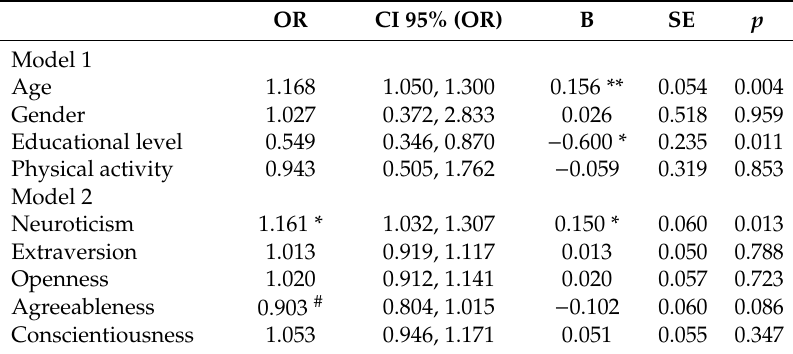
Table 2. Relationship between personality traits and metabolic syndrome (MetS).